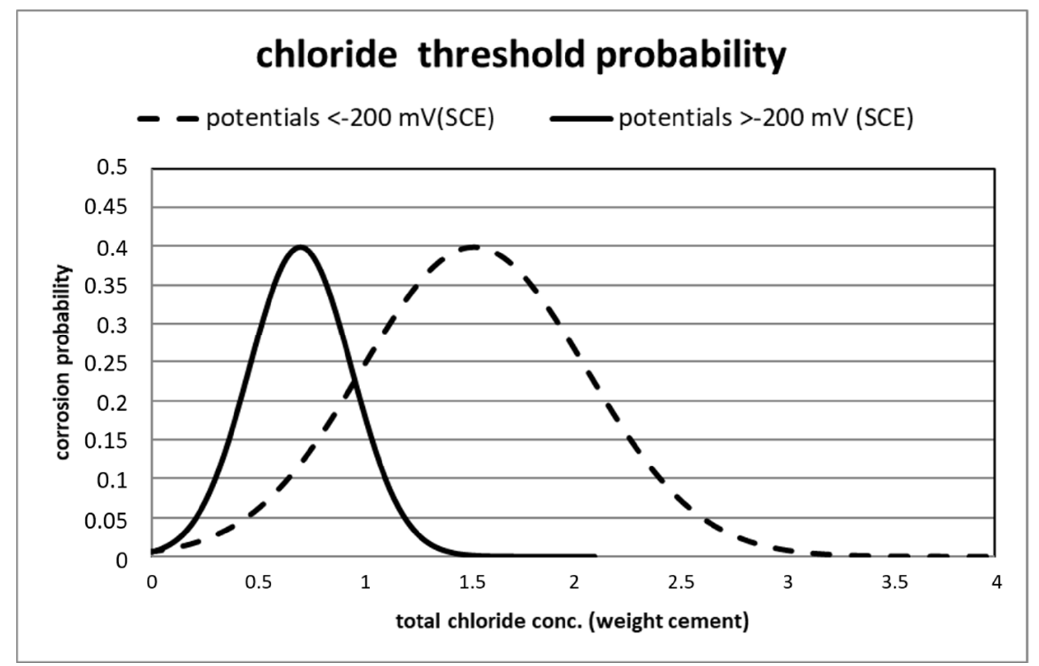
Figure 7. Statistical distributions of the chloride threshold [15] made in laboratory conditions for two ranges of potential: more anodic than −200 mV SCE potentials typical at atmospheric conditions and more cathodic than −200 mV SCE potentials typical of submerged conditions. (SCE = saturated calomel electrode).